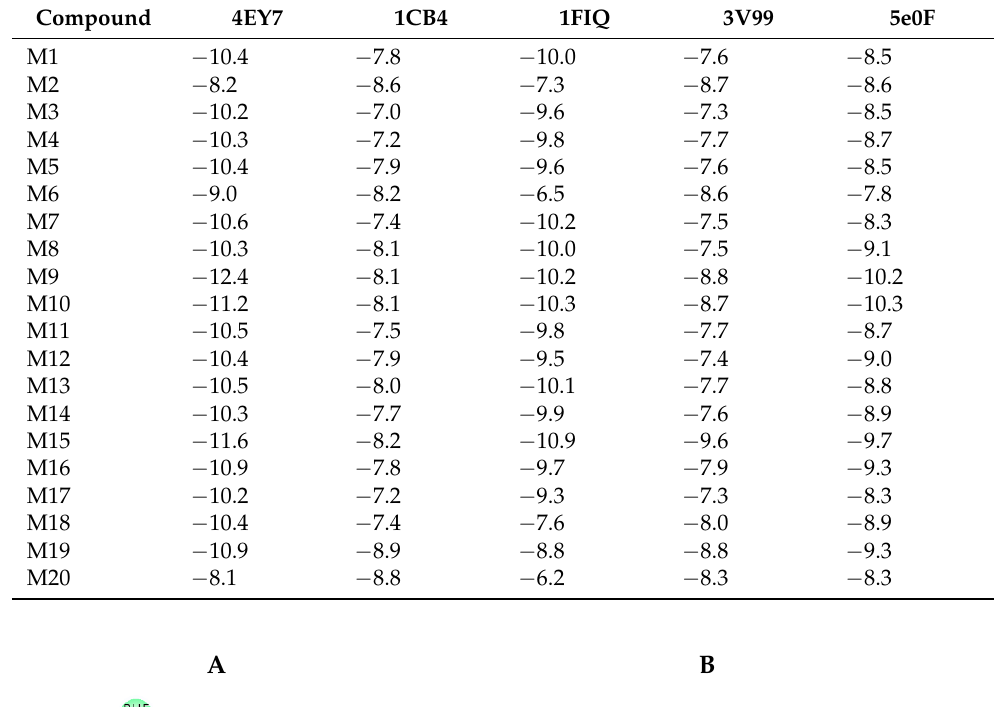
Table 5. Docking binding energies (kcal mol − 1 ) of the compounds into the active site of acetyl- cholinesterase (4EY7), superoxide dismutase (1CB4), xanthine oxidase (1FIQ), 15-lipoxygenase (3V99), and α -amylase (5e0F). Compound 4EY7 1CB4 1FIQ